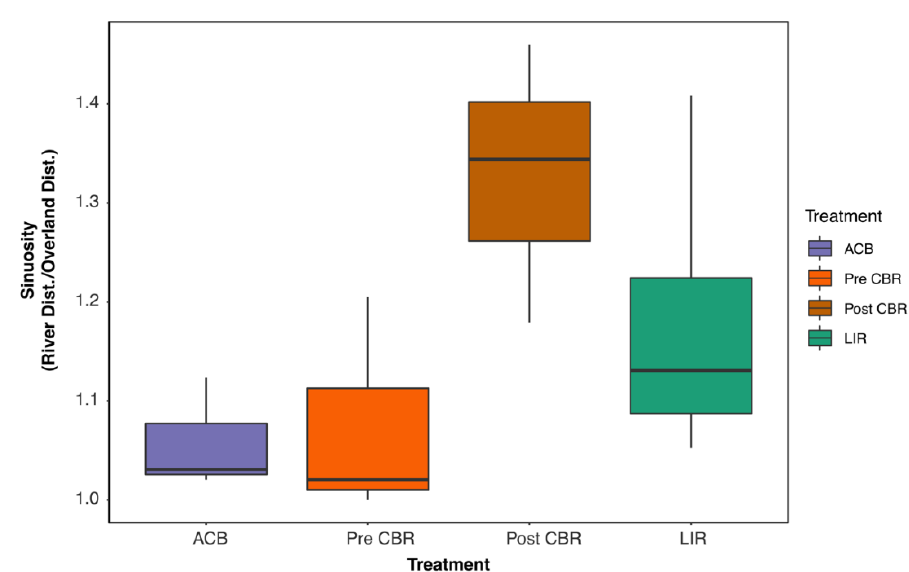
Figure 8. Sinuosity at ACB (n = 3) and LIR (n = 4), as well as pre- (n = 3) and post-restoration (n = 3) at CBR. Treatments were not significantly different ( α = 0.05). ACB and LIR sinuosity were unchanged in the same time period. ACB = active cranberry bog, CBR = cranberry bog restoration, LIR = least impacted reference.